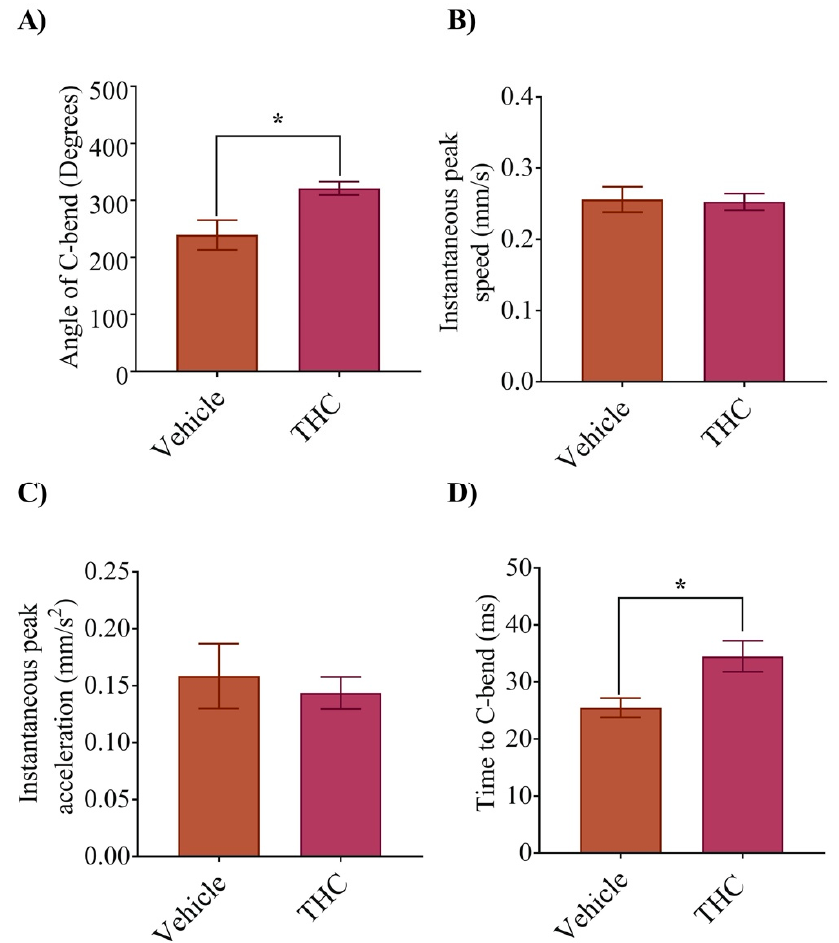
Figure 2. Exposure to THC during gastrulation alters escape response parameters. Analysis and quantification of C-bend parameters was carried out at 2 dpf. Zebrafish embryos exhibit a C-bend in response to a jet of water directed at the head just behind the eyes. ( A ) Bar graph shows the maximum angle of bend for vehicle and THC-treated (6 mg / L) embryos. ( B ) Shows the instantaneous peak speed (mm / s) during c-bend. ( C ) Shows the instantaneous peak acceleration during C-bend. ( D ) Bar graph showing the time for the tail to bend to the maximum angle. * Significantly di ff erent from vehicle control, p < 0.05.